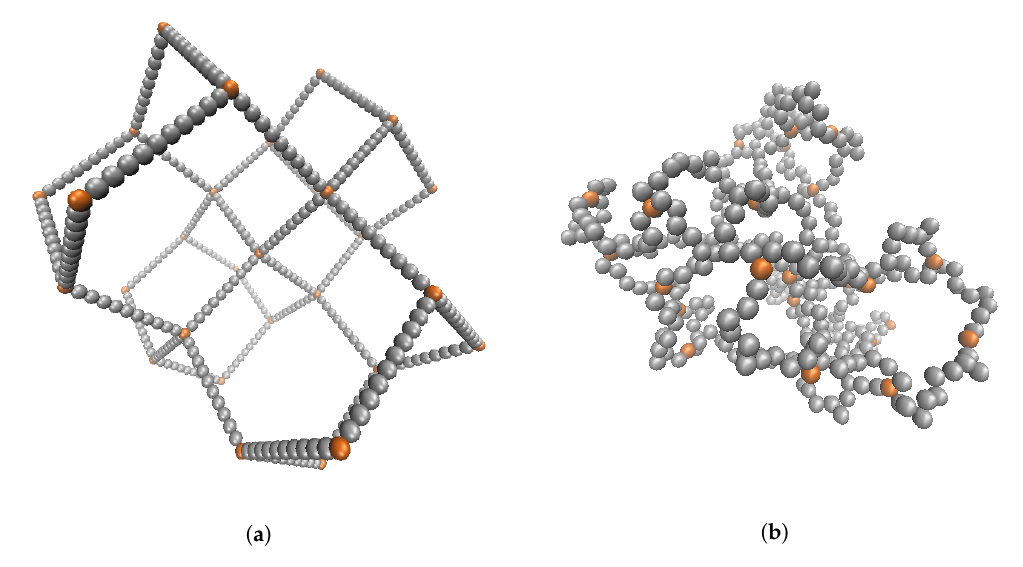
Figure 1. (Color online) Simulation screenshot of the initialized state of 29 crosslinks attached with 40 polymers having 10 monomers in each chain for a total of N 0 = 429 simulation beads. Screenshots shown immediately after the initial placement of the beads ( a ) and after equilibration ( b